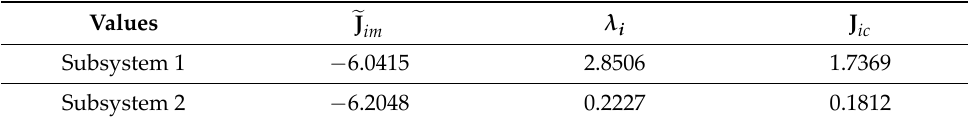
Table 1. Specific values of simulation.